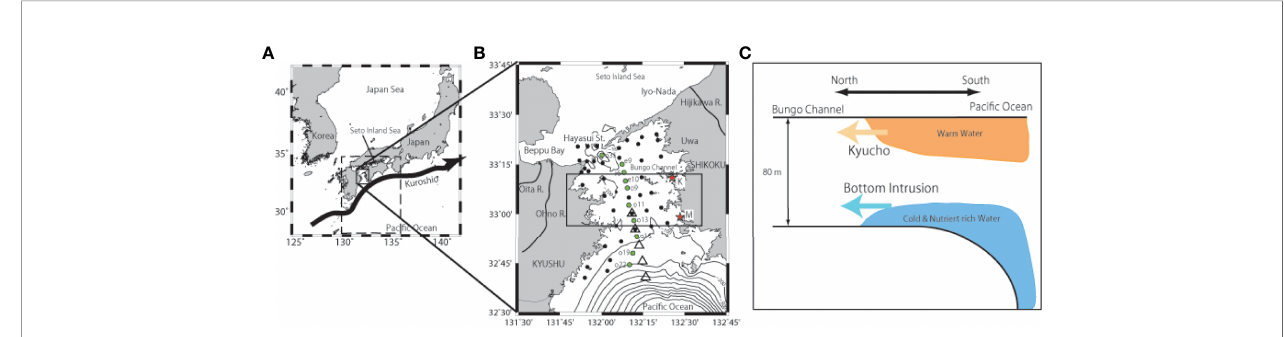
FIGURE 1 | (A) Map of Japan. The dashed square indicates the numerical model domain; the solid square is enlarged in (B) . (B) Topography around the Bungo Channel and observed points. Contour lines denote the bottom topography every 100 m of depth. Both black and green dots show the Ehime and Oita Prefecture hydrographic observation stations. Figure 5 uses the hydrographic data of green dots stations. The temporal variation in water temperature was measured at stations marked with red stars. Triangles show nutrient observation points. The black square indicates the area of control volume. (C) Schematic of intrusion phenomena in the Bungo